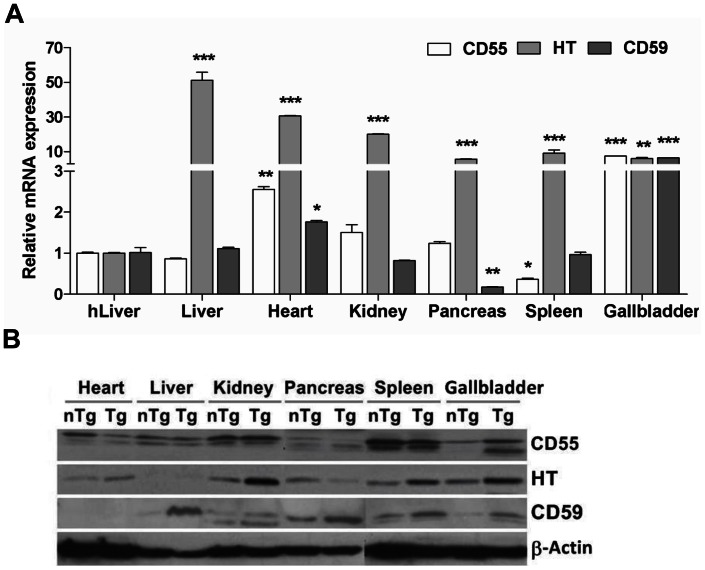
Transgene expression levels at different organs of a transgenic pig.(A) Each value derived from transcripts of the transgene in various organs of a transgenic pig (#1), after normalization relative to β-Actin (internal control) genes, were compared with that of a human liver sample defined as 1. (B) The expression of hCD55, hCD59, and HT proteins was analyzed by Western blotting. The results showed that the transgenes were detectable in most, but not all organs examined (heart, liver, kidney, pancreas, spleen, and GB).